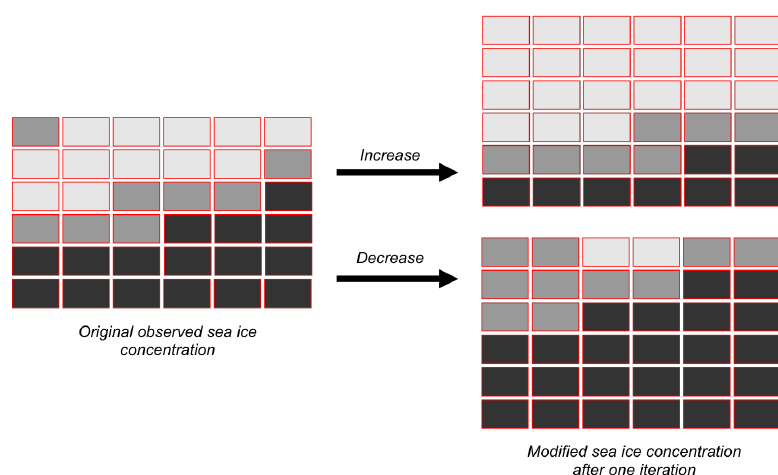
Figure 2. Iteratively constructing a “corrected” future SIC field using the iterative relative anomaly method (see Sect.